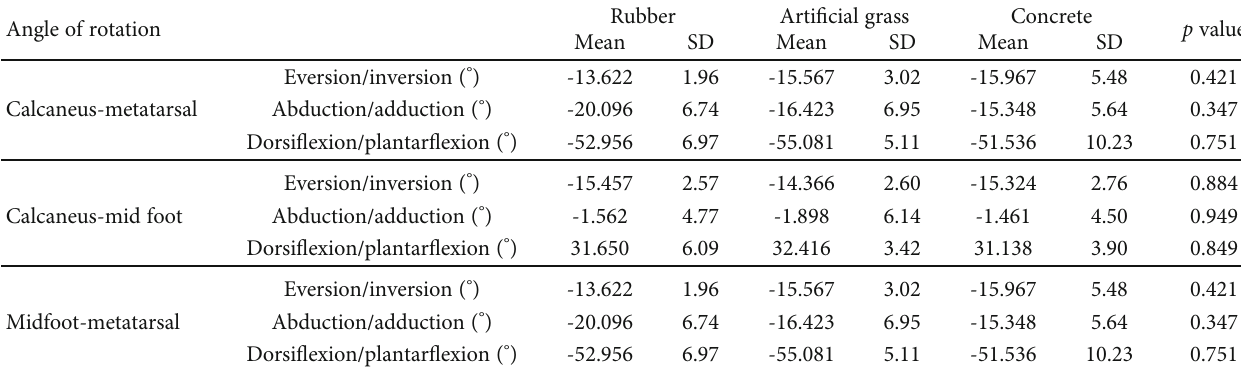
Dorsi fl exion/plantar fl exion ( °